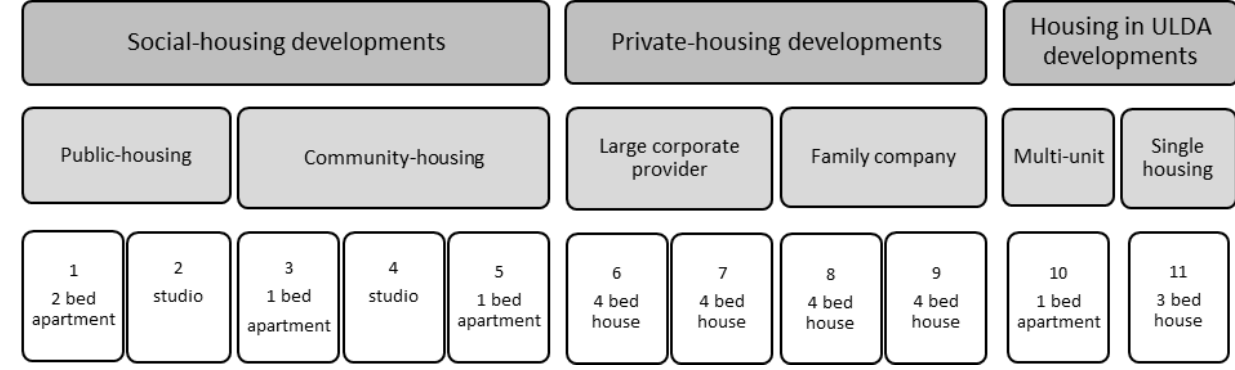
Figure 1. Description of dwellings in their housing